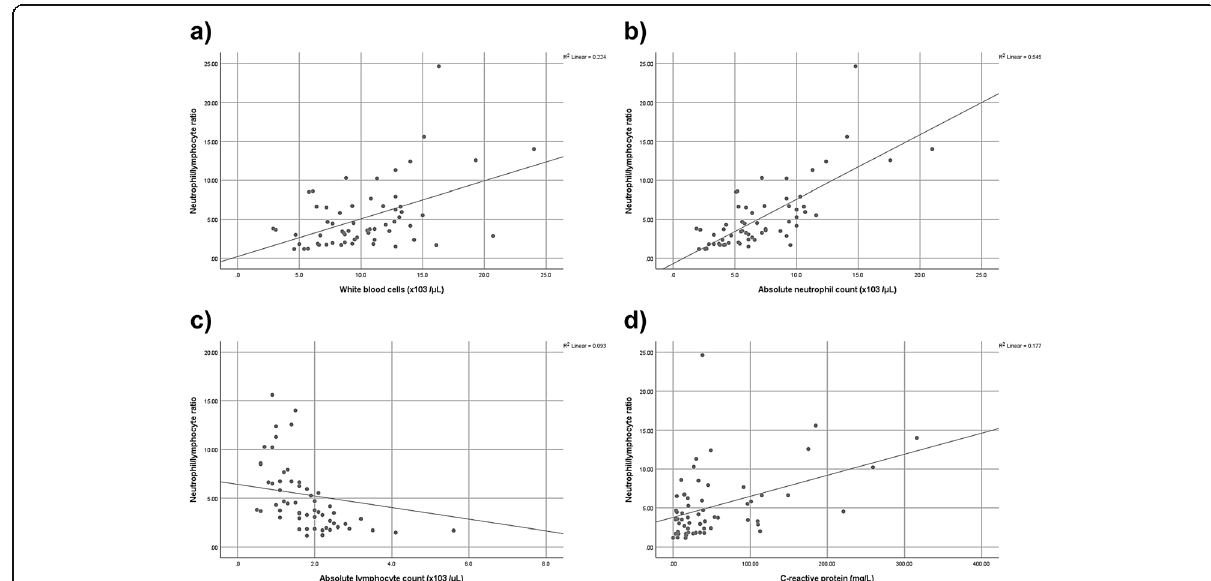
Fig. 3 Correlation coefficient of variables with neutrophil/lymphocyte ratio in acute ischemic stroke patients. *Significant. NLR, neutrophil/lymphocyte ratio; WBC, white blood